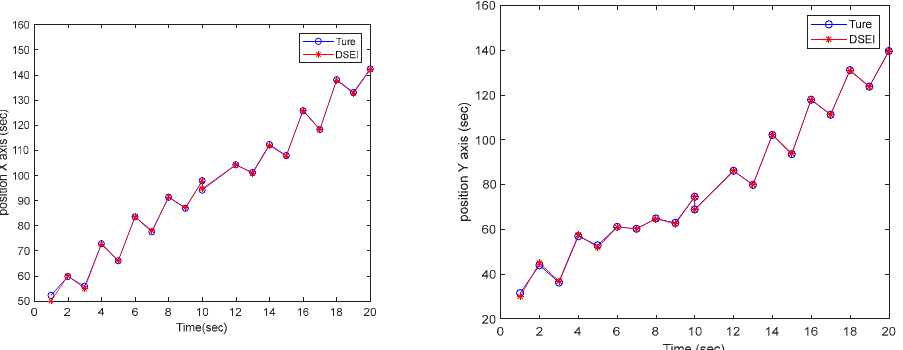
Figure 4. The target tracking performance of the DSEI fusion estimator in the X -axis and Y -axis directions.